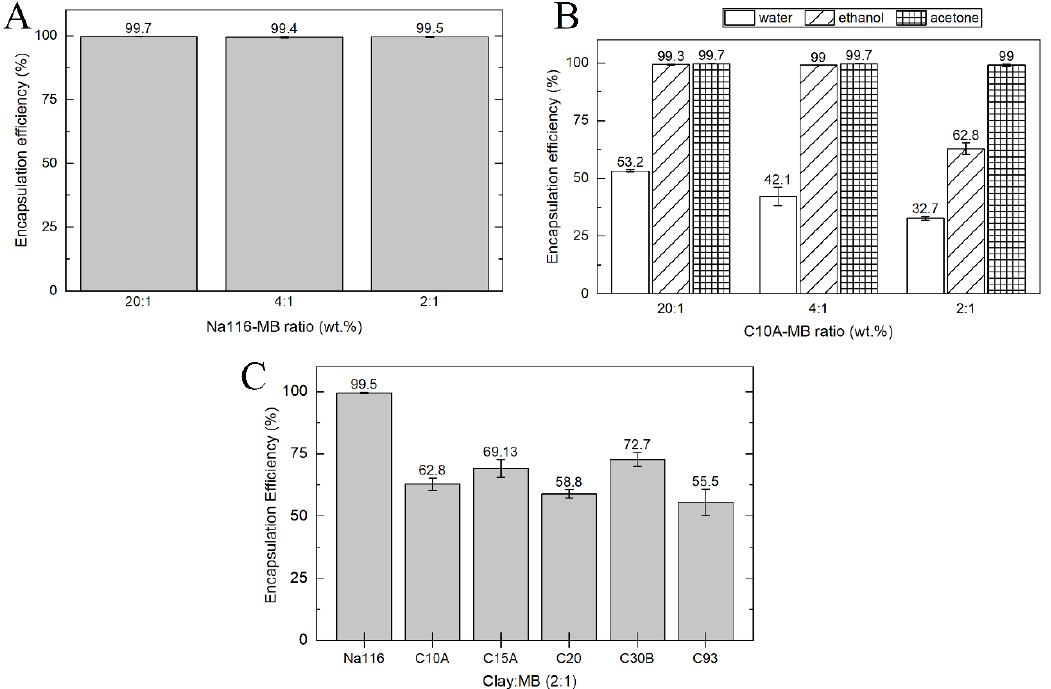
Figure 8. MB EE for ( A ) different Na116-MB weight ratios, prepared in water; ( B ) different C10A-MB weight ratios prepared in different solvents without sonication and ( C ) all clay–MB in a 2:1 ratio prepared in water (Na116) and ethanol (OMMT).